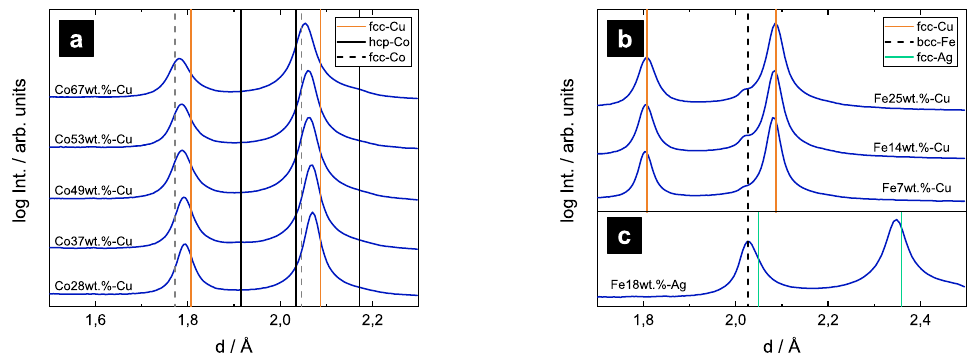
Figure 4. Synchrotron XRD patterns of as-deformed samples. In the patterns of Co-Cu samples ( a ), only one set of fcc-peaks remains; ( b ) XRD patterns of Fe-Cu samples show pronounced fcc-Cu peaks and weak bcc-Fe peaks. In the XRD pattern of Fe18wt.%-Ag, ( c ) bcc-Fe and fcc-Ag peaks